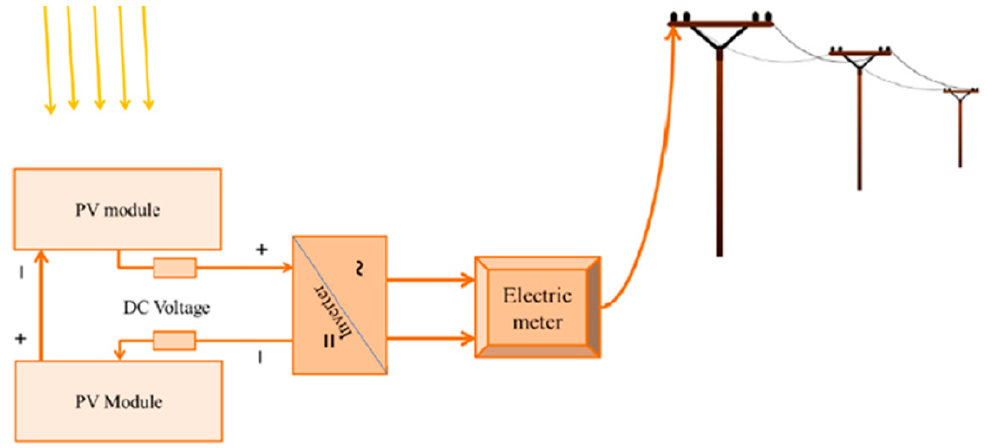
Figure 5. The overview of the proposed solar PV system.